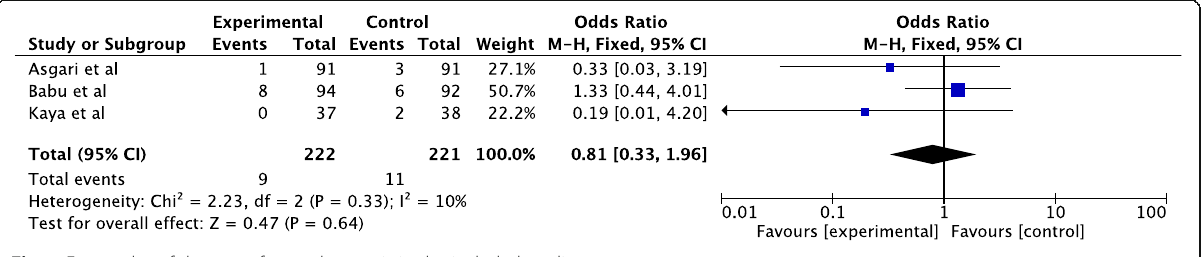
Fig. 4 Forest plot of the rate of meatal stenosis in the included studies